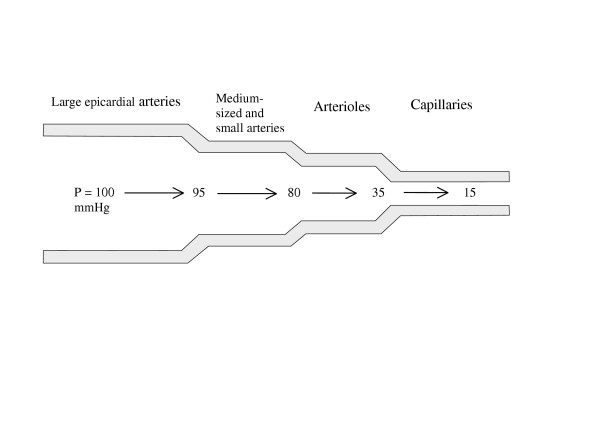
Sequential decrease of coronary perfusion pressure in consecutive segments of coronary vasculature. The largest fall in perfusion pressure occurs in coronary resistance arterioles.